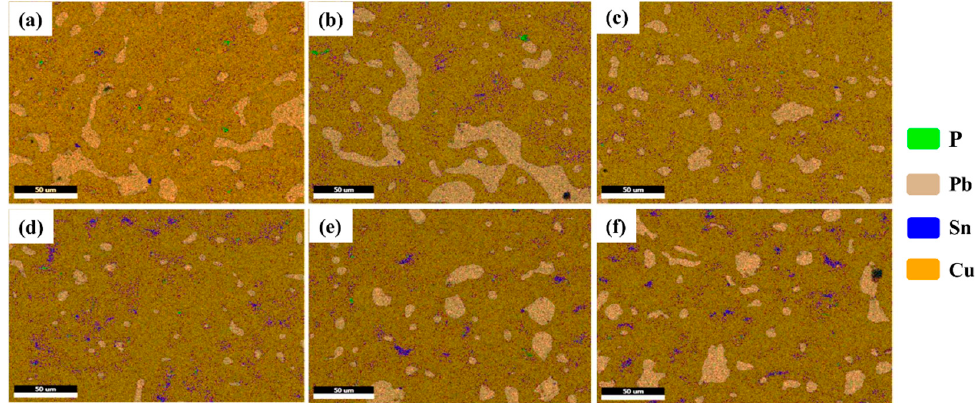
Figure 8. The distribution of elements in the copper layer at different solidification